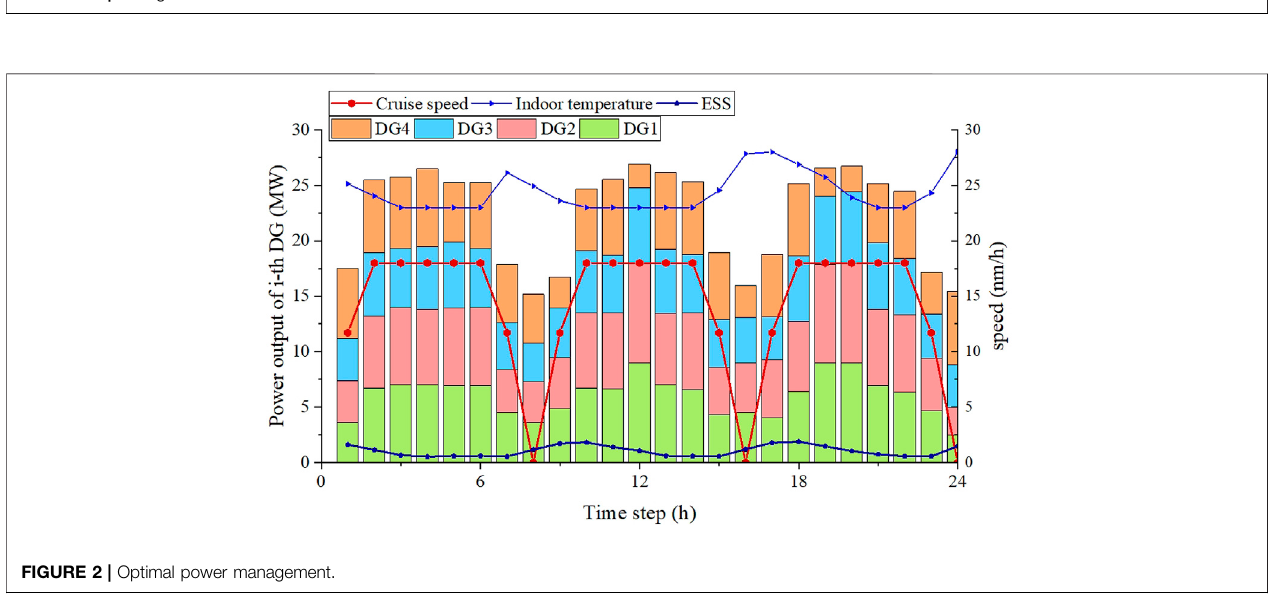
FIGURE 1 | Con fi guration of an AES.